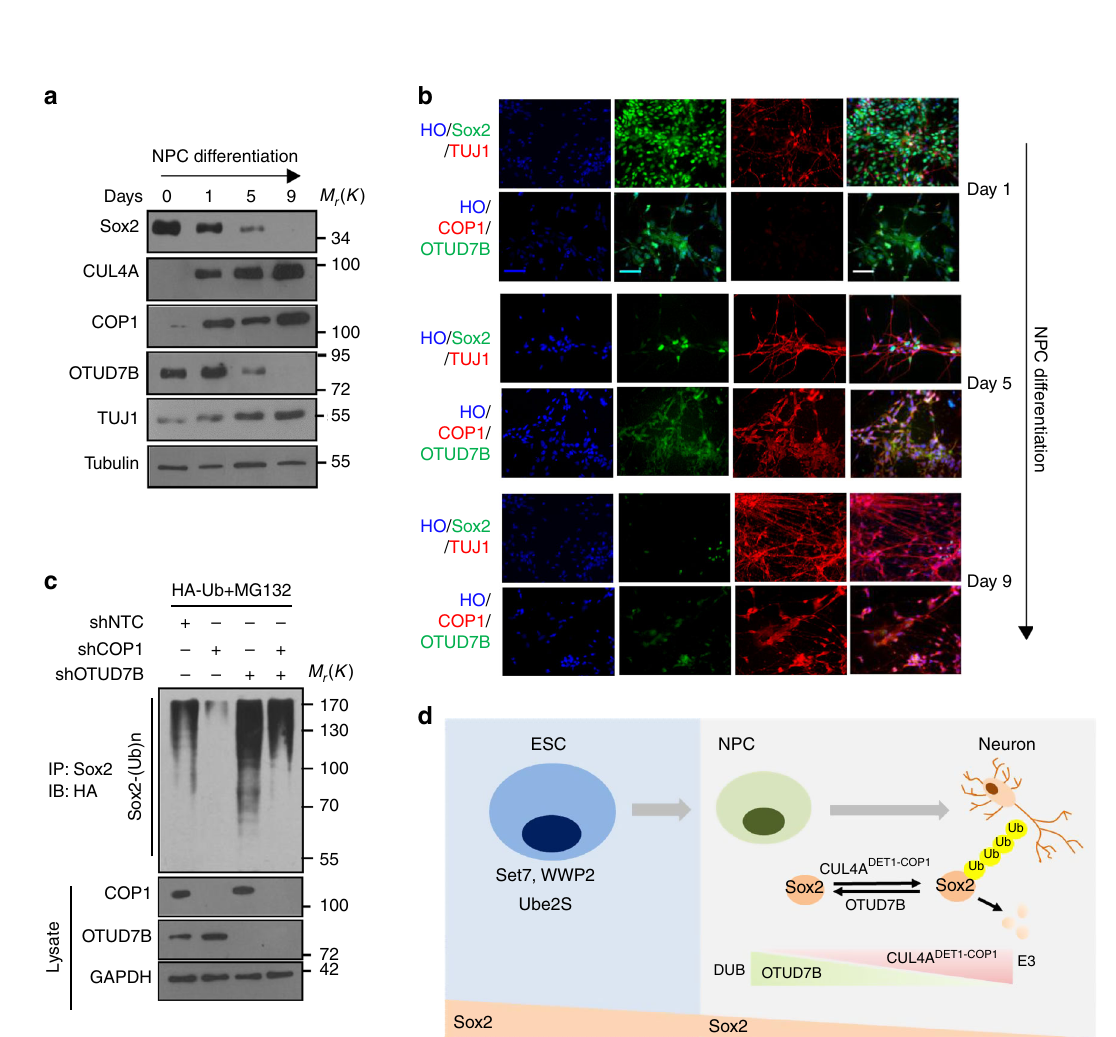
Fig. 8 COP1 and OTUD7B coordinate to control NPCs differentiation. a , b NPCs were plated in Matrigel-coated six-well plate for neuronal differentiation. For the indicated times, immunoblotting ( a ) and immuno fl uorescence ( b ) of Sox2, CUL4A, COP1, OTUD7B and TUJ1 were performed. c Cells transfected with HA-Ub and indicated shRNA were treated by MG132 for 8 h, and the lysates were immunoprecipated with anti-Sox2 antibody and immunoblotted with anti-HA. d Summary of our fi ndings. OTUD7B stabilizes Sox2 through deubiquitylation and maintains the stemness of NPCs, while CUL4A DET1-COP1 promotes Sox2 degradation through ubiquitylation and induces differentiation of NPCs. OTUD7B and CUL4A DET1-COP1 exert opposite roles in regulating Sox2 protein stability at the post-translational level. The representative images are shown from three independent experiments. Unprocessed original scans of blots are shown in Supplementary Fig.